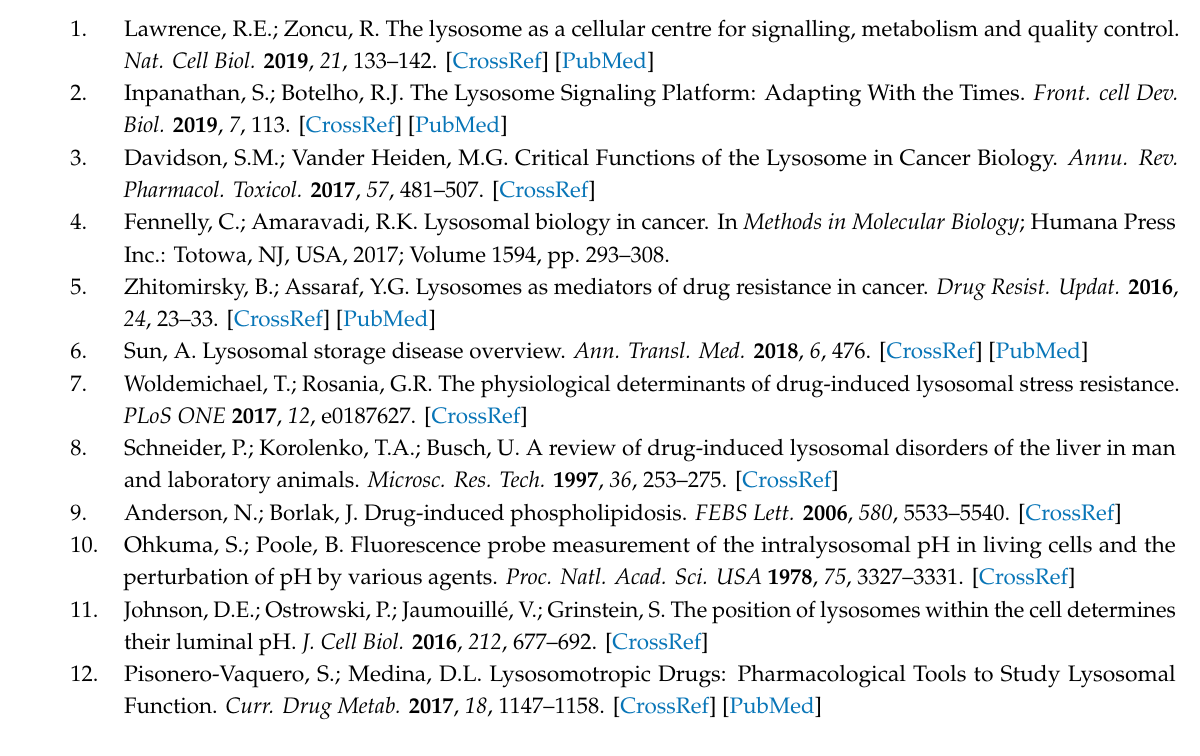
Figure S1: Structure and physicochemical properties of various compounds employed in the current study, Figure S2: Increased size and number of LAMP1-mGFP labeled lysosomes following treatment with CNSDs, Figure S3: Representative quantification of the increase in lysosomal parameters following CNSDs treatment, Figure S4: ILVs contain marked levels of the anticancer drugs DNR and NTD, Figure S5: CpHMD simulations of membrane insertion of lysosomotropic anticancer drugs, Figure S6: Selected conformations of LDs inserted into a DMPC membrane